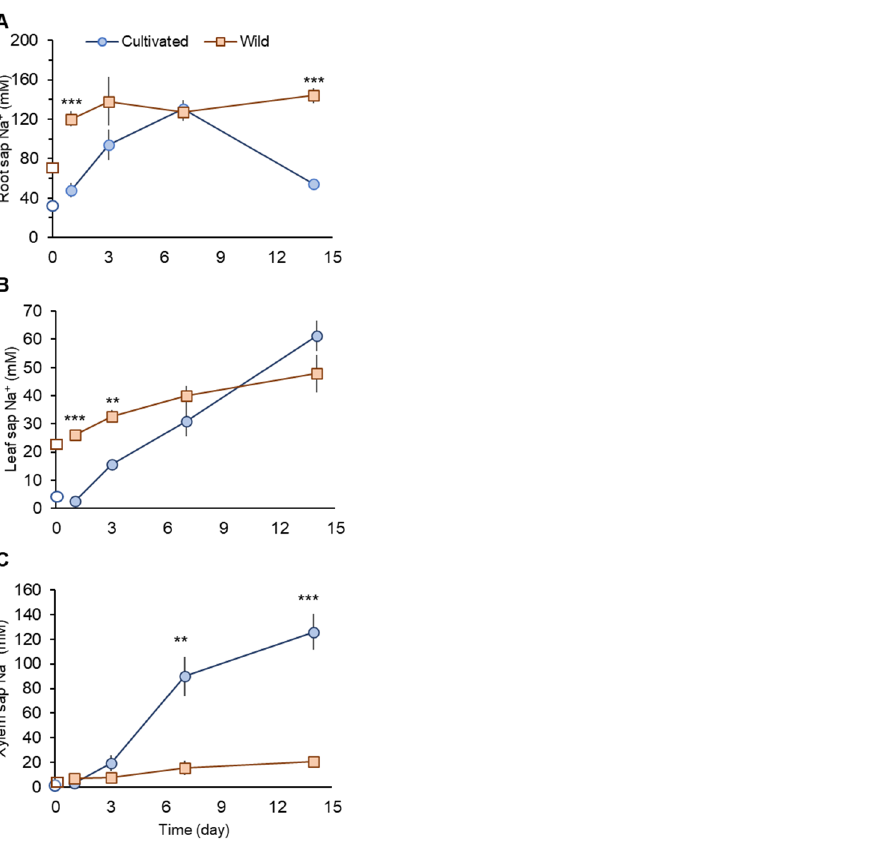
Figure 3. Na + concentrations in root ( A ), leaf ( B ), and xylem sap ( C ) in cultivated and wild rice species under 100 mM NaCl treatments at different time points after the commencement of salinity. Open symbols describe Na + concentrations before salinity onset. Asterisks indicate significant differences between plant species within the same harvest day. (** p < 0.01; *** p < 0.001, Student’s t -tests). Mean ± SE ( n = 3–6).